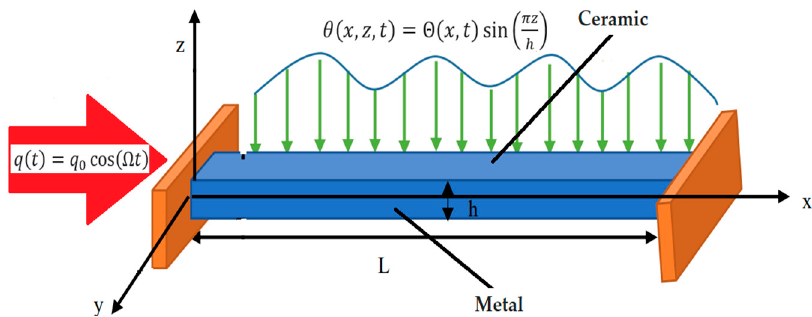
Figure 1. Configuration of FG thermoelastic nanobeam .